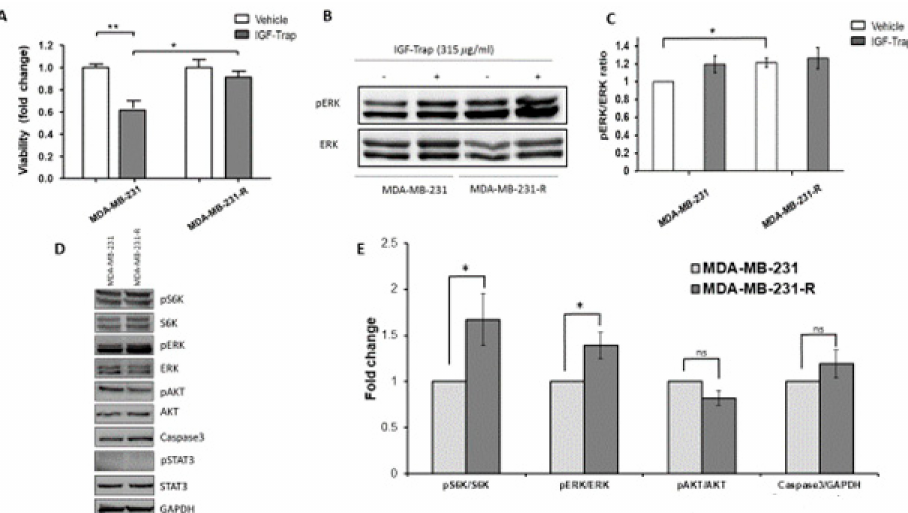
Figure 3. Acquired resistance to the growth inhibitory effect of IGF-Trap and augmented ERK signaling following sustained exposure of MDA-MB-231 to IGF-Trap in vitro. MDA-MB-231 exposed to gradually increasing concentrations of IGF-Trap for 3 months (MDA-MB-231-R) and the parental cells were treated with the IGF-Trap (315 µ g/mL) for 72 h. Cell proliferation was measured using the MTT assay. Shown in ( A ) are means ± SE of the results ( n = 5) expressed as fold change relative to the respective vehicle-treated controls that were assigned a value of 1. ERK activation ( B ) was analyzed by Western blotting. Shown in ( B ) is a representative immunoblot and in ( C ) the means ± SE ( n = 3) expressed as fold change in the pERK/ERK ratio relative to vehicle-treated cells that were assigned a value of 1. Shown in ( D ) is a representative Western blot of additional signal transduction mediators analyzed in these cells, and in the bar graph ( E ) the means ( ± SE) of 3 experiments expressed as phosphorylated to total protein ratios normalized to the levels of parental MDA-MB-231 cells that were assigned a value of 1. * p < 0.05, ** p < 0.01, ns—not